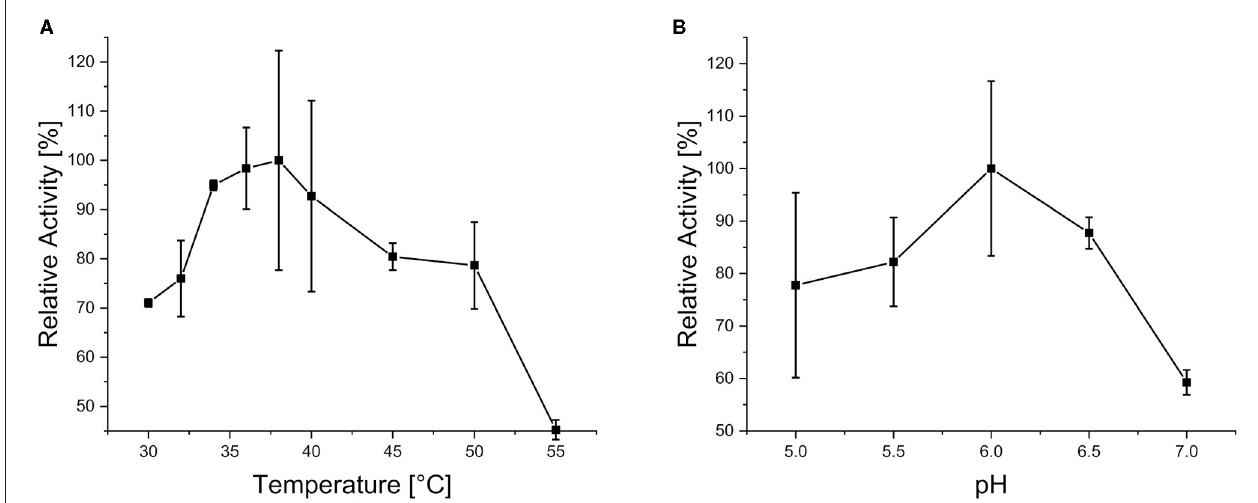
FIGURE 5 | Biochemical characteristics of X11Nc when using purified beechwood xylan as substrate. Activities are given in relation to the strongest activity at different reaction temperatures (A) and at different reaction pH values (B) .